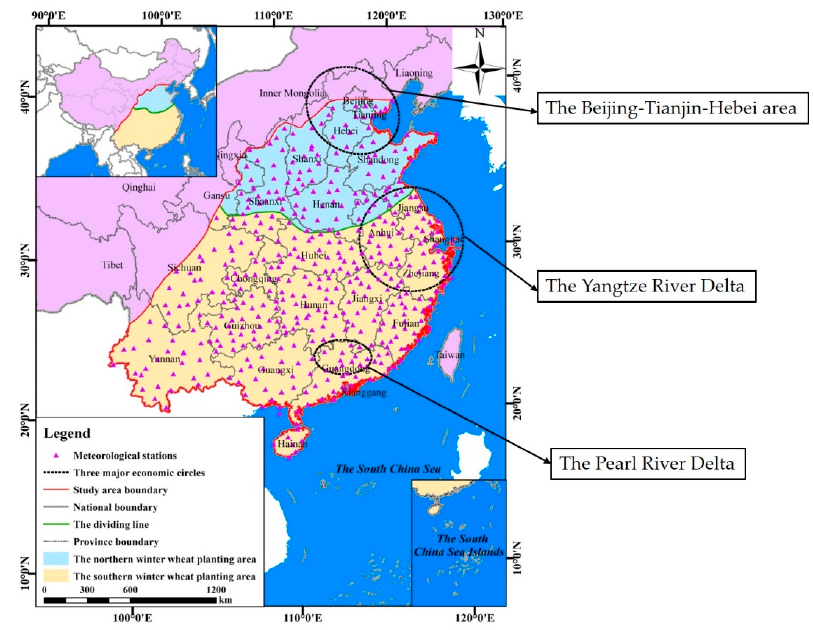
Figure 1. Distribution map of winter wheat planting areas and meteorological stations in China